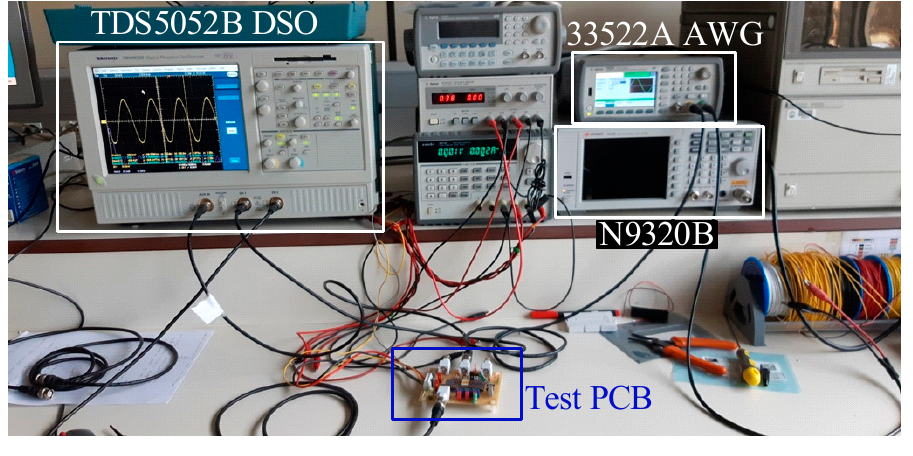
Figure 9. Measurement setup.